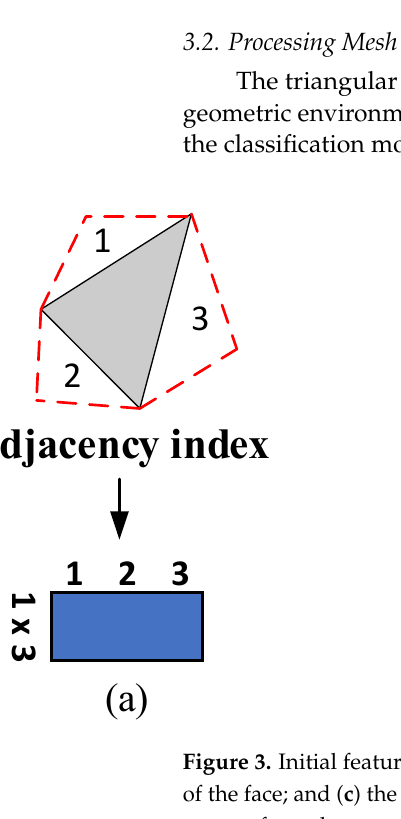
4 of 11 Figure 2. Algorithm flow chart. (After feature extraction of the faces, they are input to the classifica- tion network for aggregated vertex information and then pooled to obtain global features. Finally, the classification results are output.)